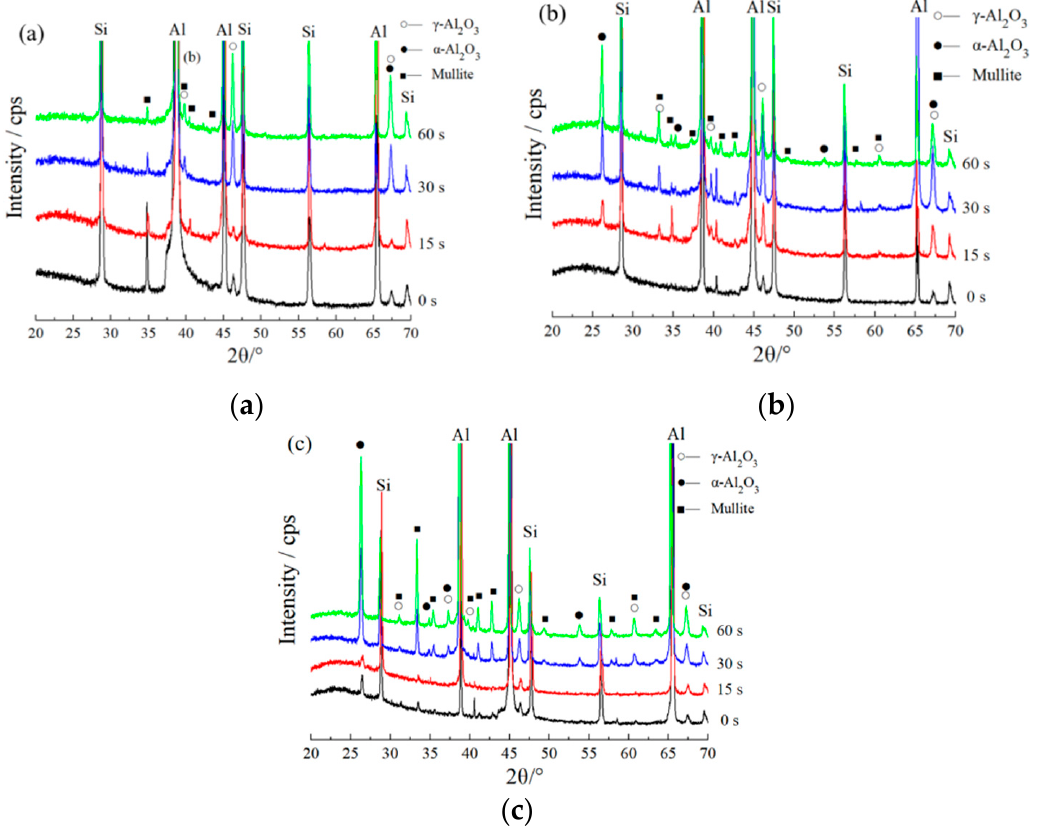
Figure 8. XRD spectra of layers on Al-12 Si by different etching times after ( a ) 10, ( b ) 20, and ( c ) 30 min. of MAO treatment, respectively.